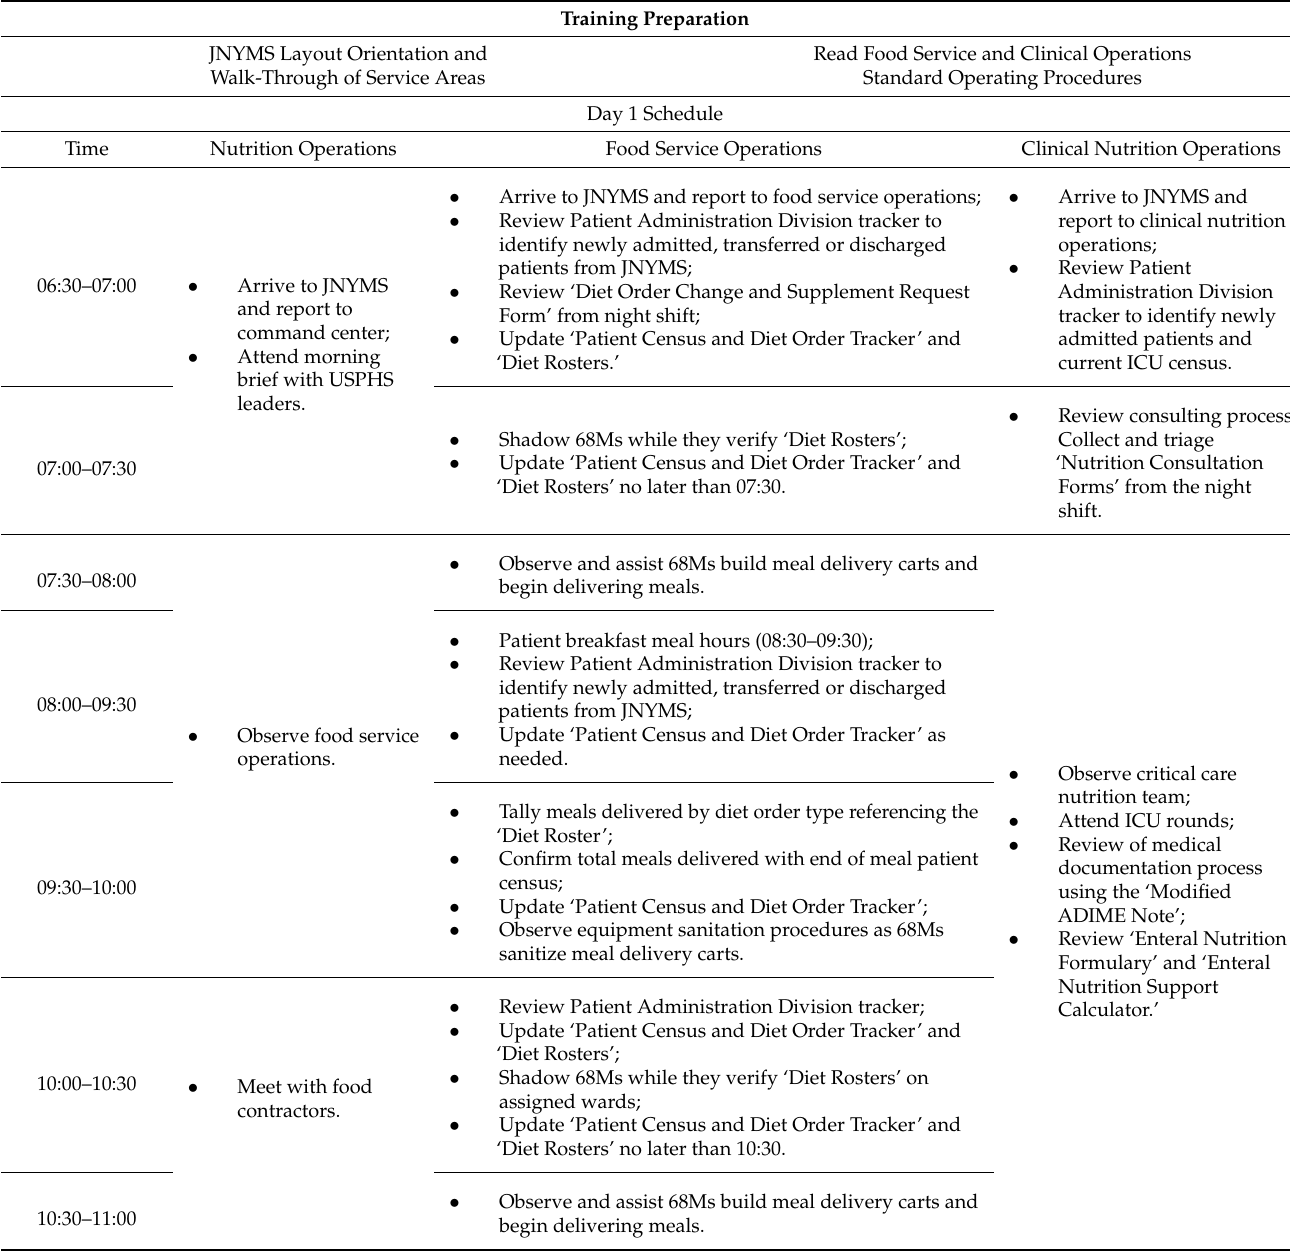
Table 6. Example of the training program syllabus, designed to identify training requirements upon the day of arrival (day 1) and for early shift (a.m.)